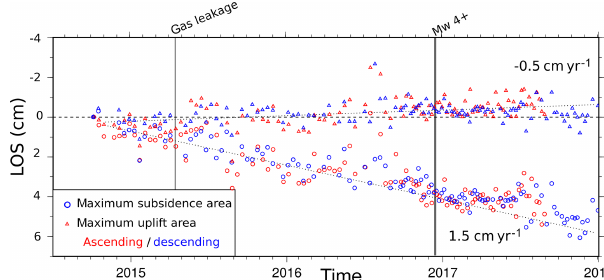
Figure 7. Displacement time series for the most subsiding and up- lifting areas (3 × 3 pixels) on both tracks (ascending is red, descend- ing is blue) in the Patos-Marinza oil field (relative to a stable area). The average trend is indicated (dashed line) together with two par- ticular events (gray vertical bars) related to the field exploitation and seismic